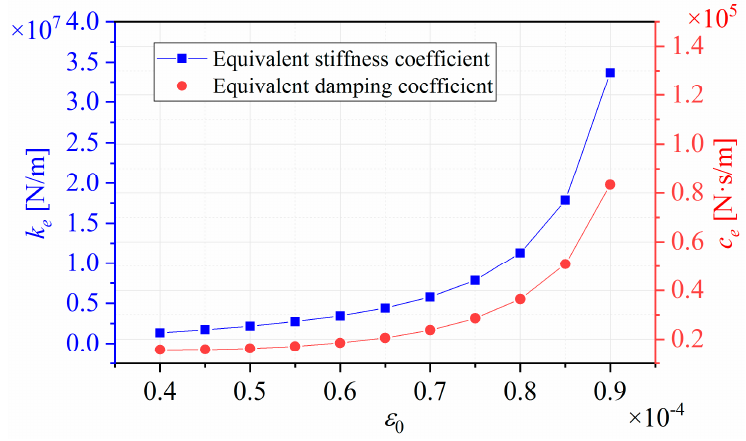
ff ness and damping coe ffi cients of MRD varied with eccentricity ratio. Figure 10. Equivalent stiffness and damping coefficients of MRD varied with eccentricity ratio. Figure 10. Equivalent sti